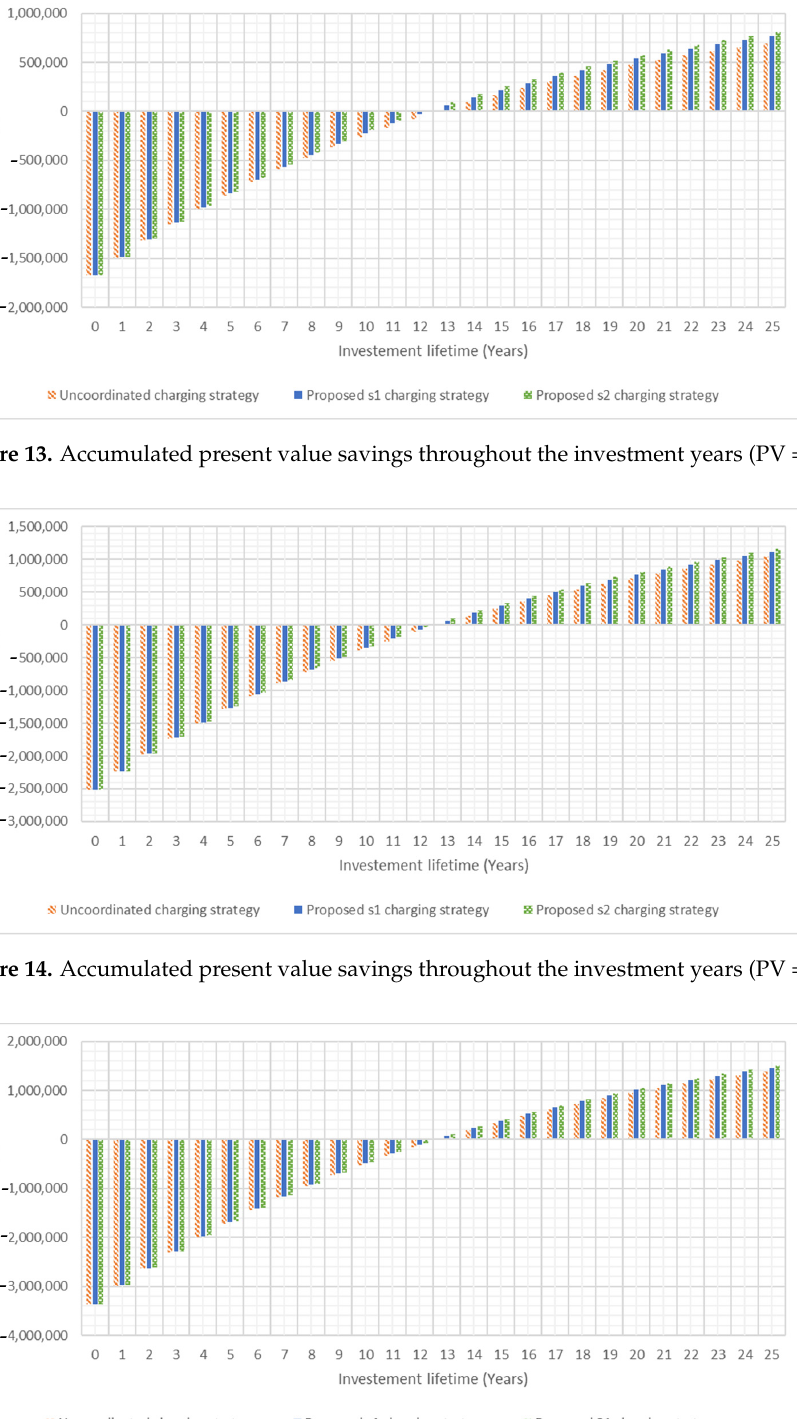
Figure 12. Accumulated present value savings and revenue throughout the investment years (PV = 1000 kWp).